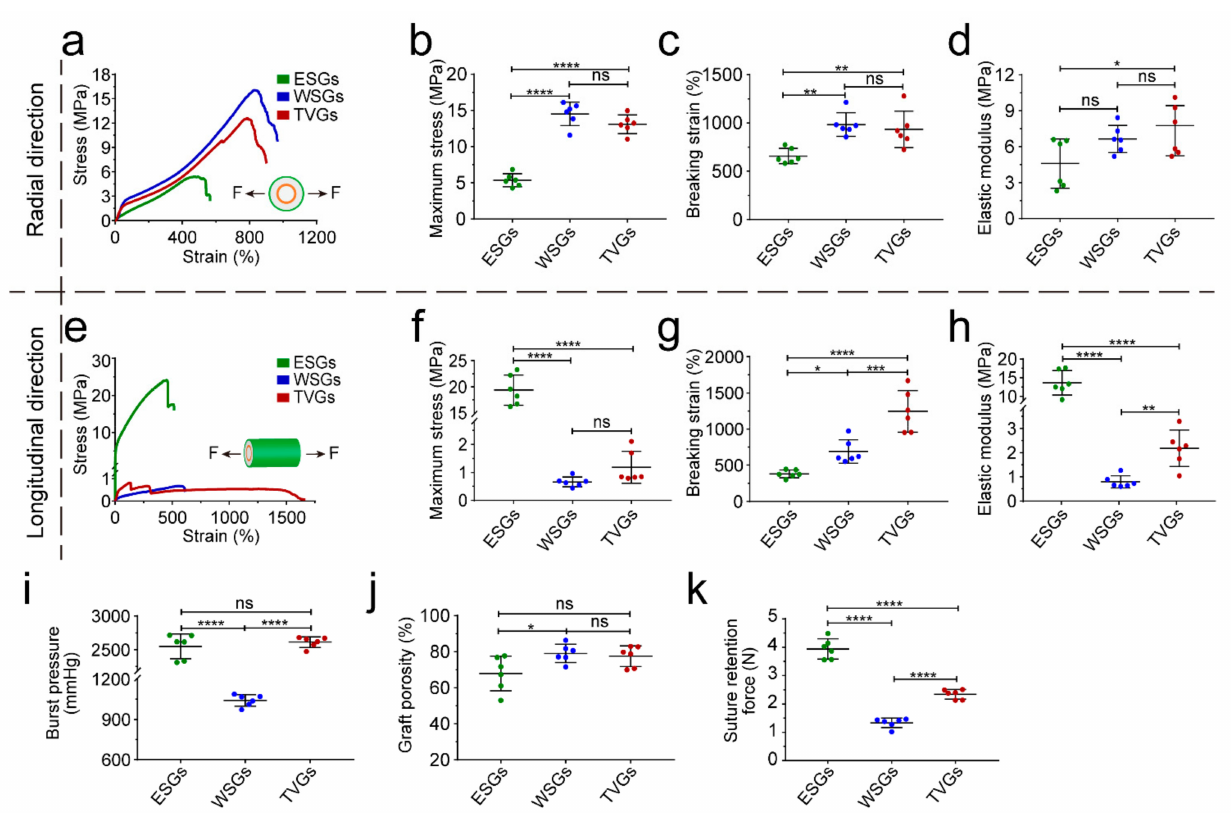
Figure 3. Mechanical analysis of various grafts. ( a – h ) Stress–strain curves ( a , e ), maximum stress ( b , f ), breaking strain ( c , g ), and elastic modulus ( d , h ) in the radial and longitudinal direction ( n = 6). Arrows indicate the tensile direction. ( i – k ) Burst pressure ( i ), porosity ( j ), and suture retention force ( k ) of grafts ( n = 6). The results are expressed as the mean ± s.d., * p < 0.05, ** p < 0.01, *** p < 0.001, and **** p < 0.0001. ns, not